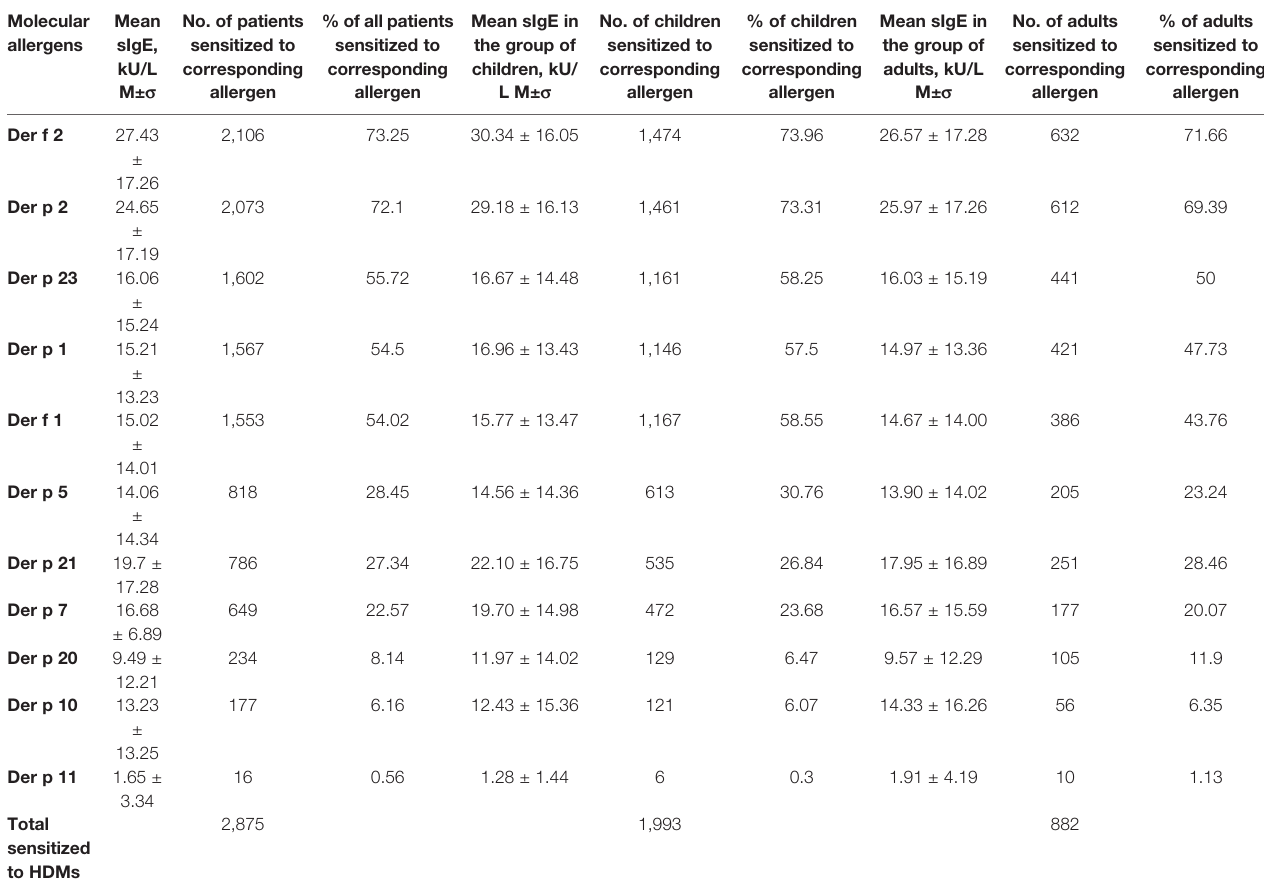
TABLE 1 | Share of patients sensitized to molecular allergens of HDMs. Molecular Mean No. of patients allergens sIgE, sensitized